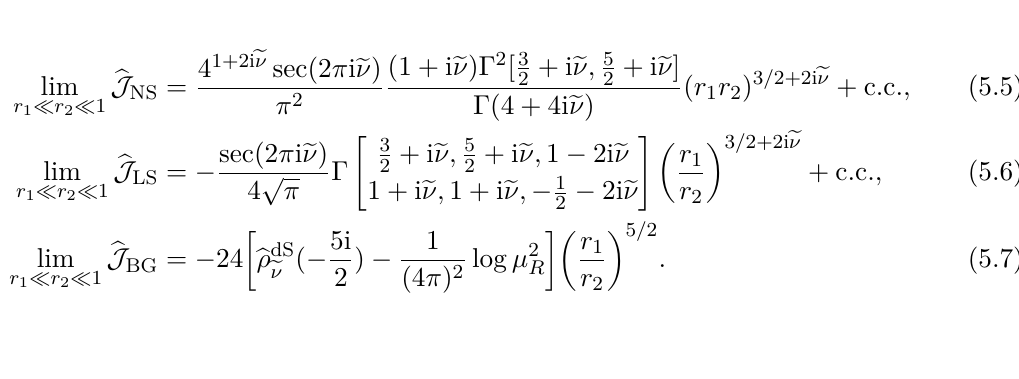
for all three terms in (5.1). The result /r 1 2